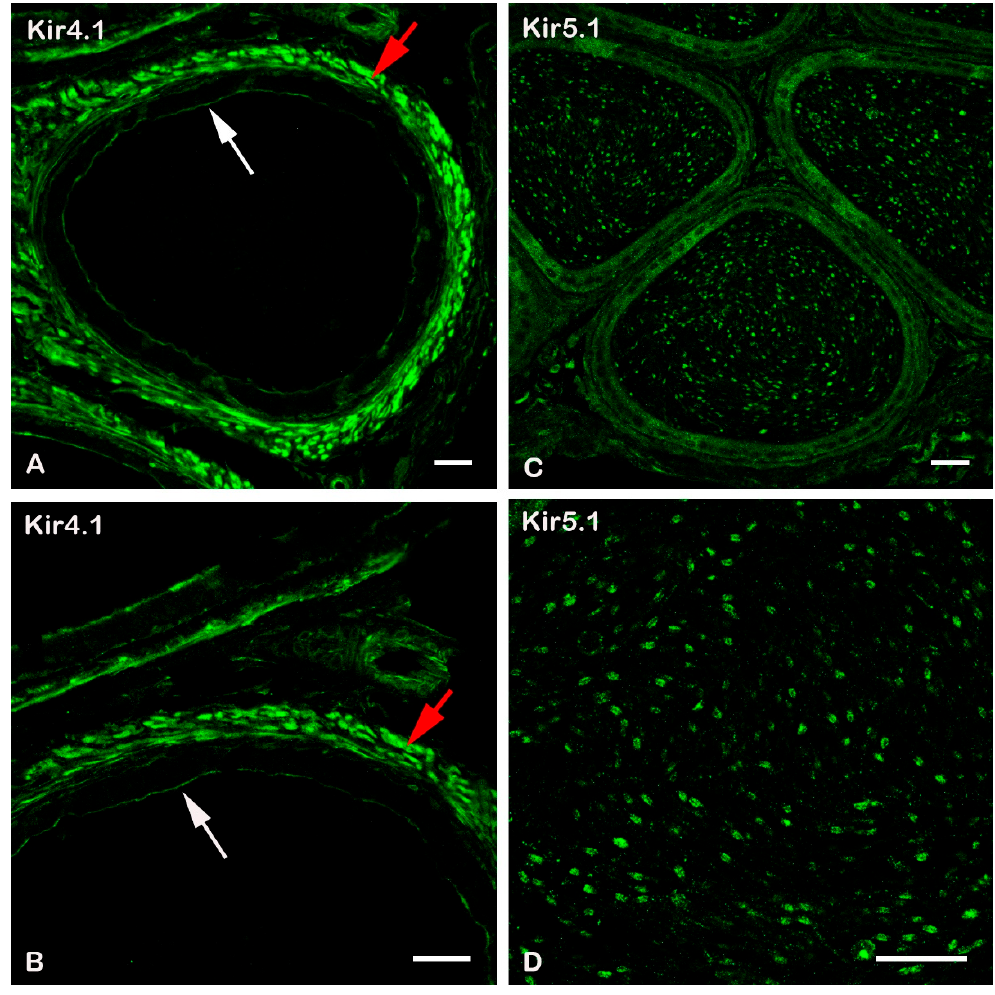
Figure 1. Expression of Kir4.1 and Kir5.1 channels in the cauda epididymis. ( A ) Kir4.1 is expressed in the epithelial cells lining the epididymal ducts (white arrow) and in peritubular smooth muscle of the cauda epididymis (red arrow). Immunoreactivity was absent in the lumen where spermatozoa are located, implying the lack of Kir4.1 expression in these cells. ( B ) Magnified image taken from the upper part of panel A. ( C ) Image showing strong expression of Kir5.1 in spermatozoa. ( D ) Magnification of the lumen of the cauda epididymis. Staining shows the localisation of Kir5.1 subunits in the head of the sperm. Scale bar in ( A ), ( B ), and ( C ) = 25 µ m, and in ( D ) = 20 µ